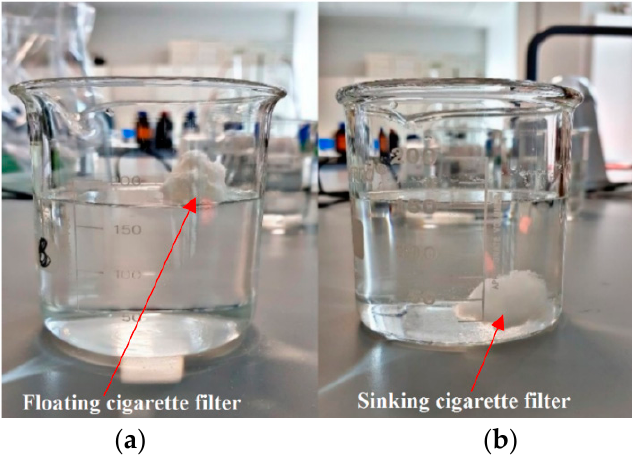
Figure 2. Hydrophobicity test using the floating method, between ( a ) functionalised cigarette filters and ( b ) un-functionalised cigarette filters.